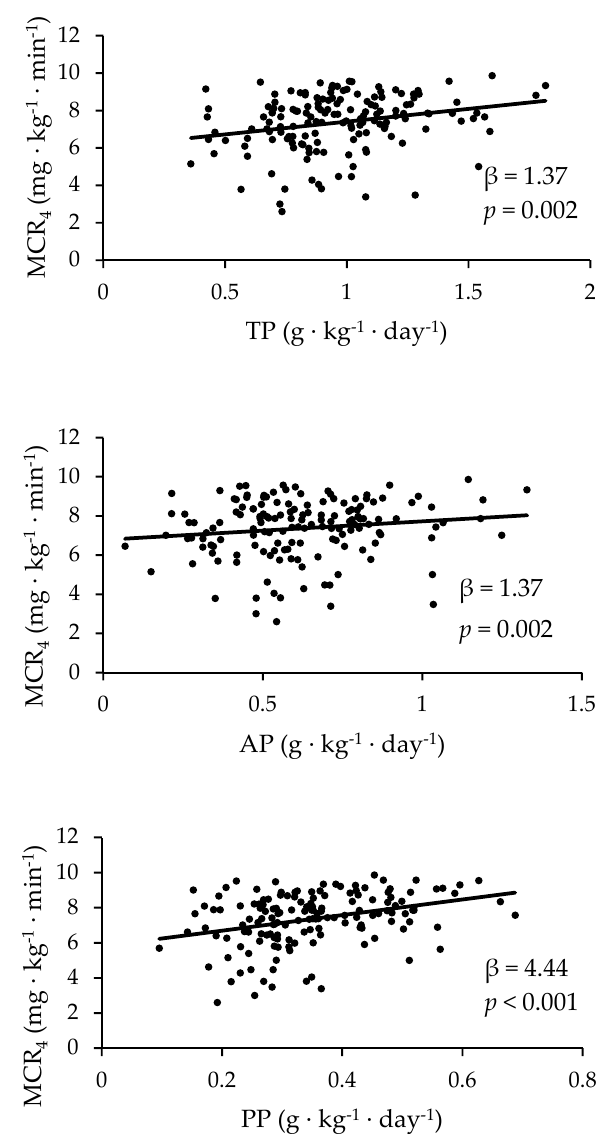
Figure 1. The unadjusted correlations of protein intake relative to the estimated metabolic clearance rate of glucose (MCR 4 ). After adjustment for BMI, the relationship between MCR 4 and protein intake weakened (TP: β = 0.64, p = 0.01; AP: β = 0.39, p = 0.43; PP: β = 2.39, p = 0.03). TP: total dietary protein intake; AP: total dietary animal protein intake; PP: total dietary plant protein intake.